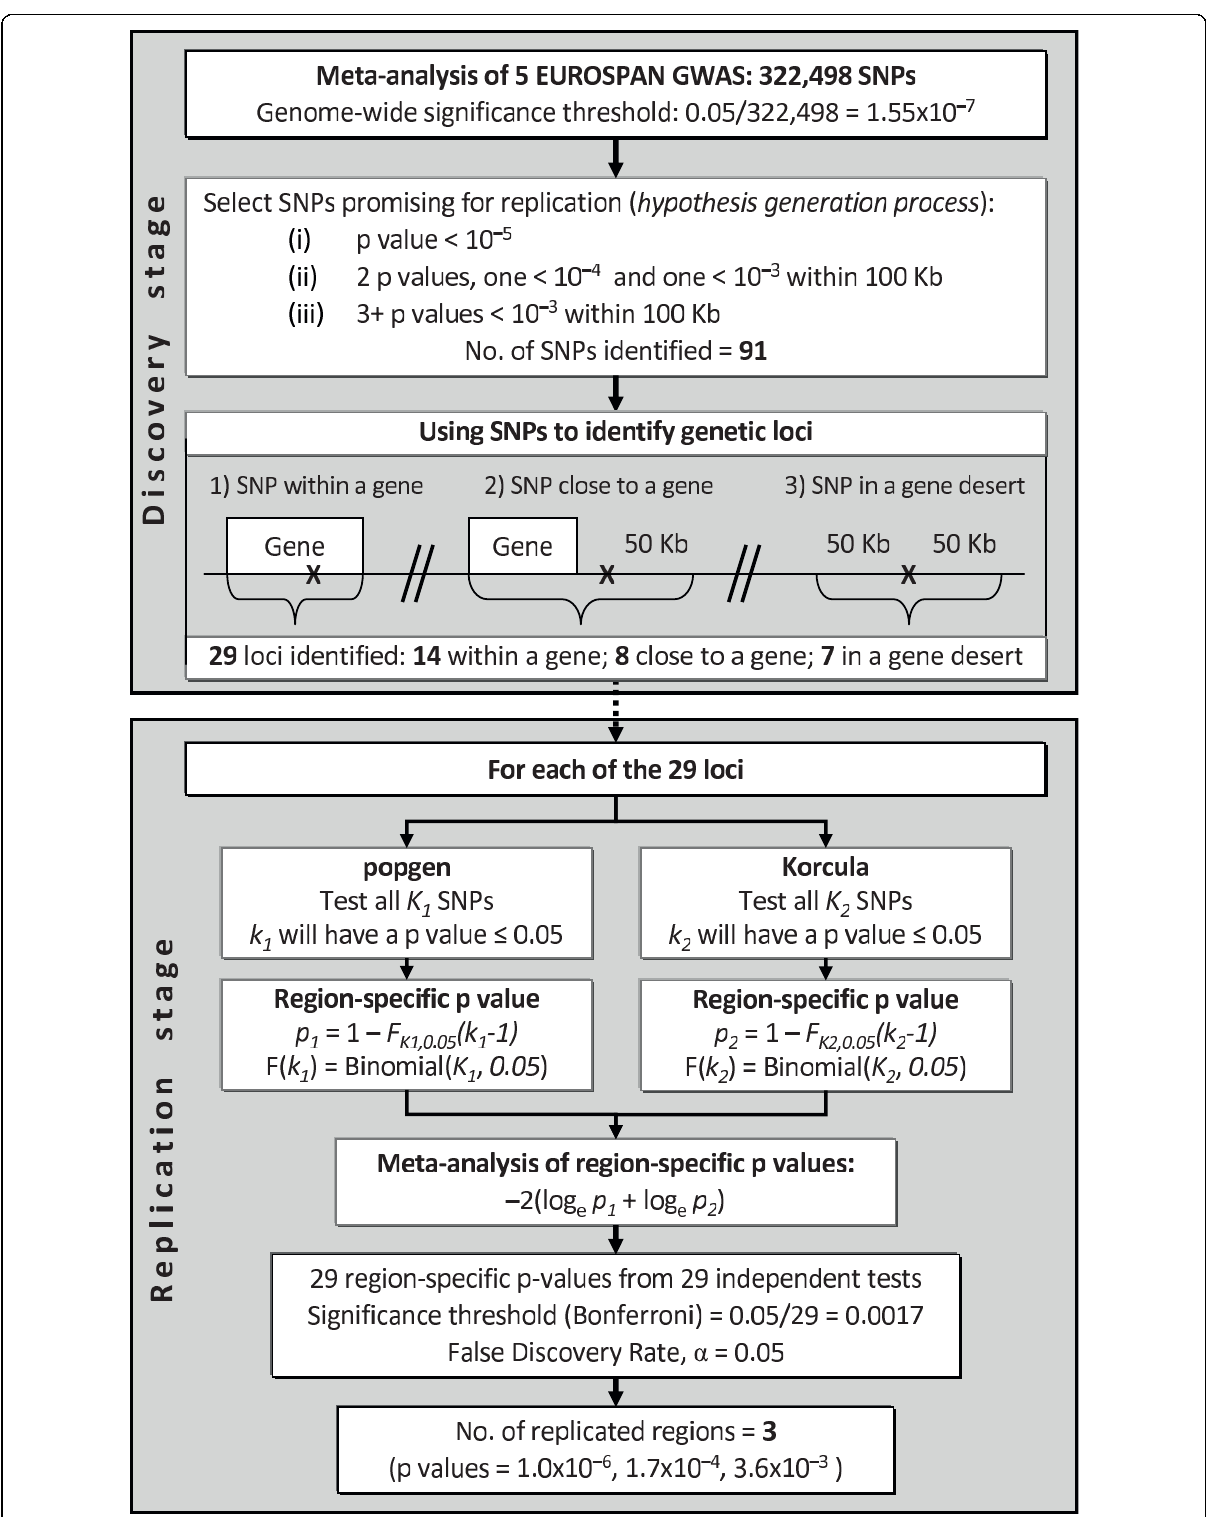
Figure 1 Workflow of the discovery and replication stages of the study (for details, see the Statistical Analysis section)